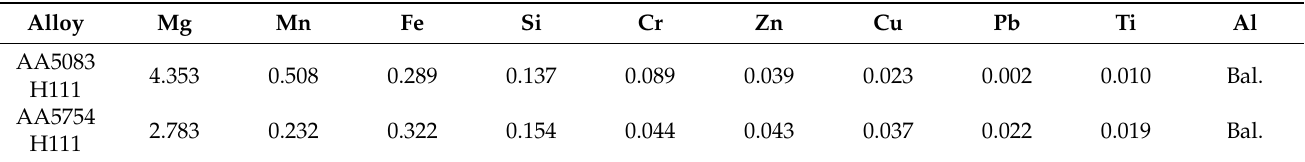
Table 1. Chemical composition of the aluminium alloys (wt%).